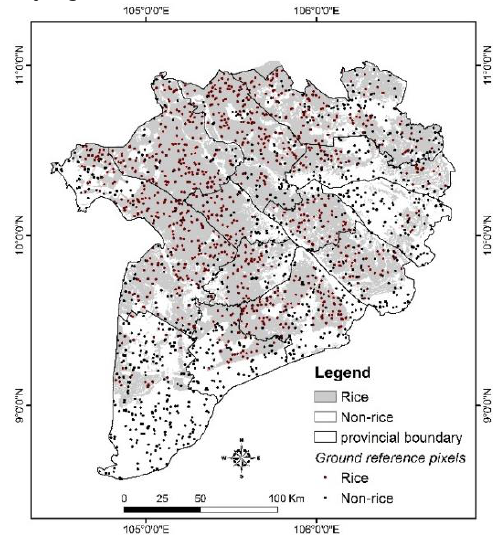
Figure 1. The location of the study region. Points extracted from the ground reference data were used for accuracy